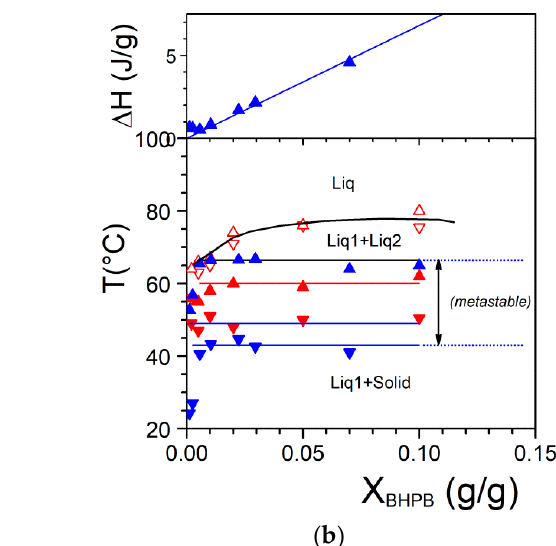
Figure 5. ( a ) A T-C phase where a monotectic transformation is observed. At the monotectic point the solid transforms into two liquids of differing compositions. The red lines show the shapes endotherms expected by DSC. The variations of the enthalpies associated with the different transitions are shown above. ( b ) Experimental example observed with BHPB-10 in trans -decahydronaphthalene (chemical structure in Appendix A Figure A3), X BHPB is in gram of organogelator per gram of gel. The red arrows stand for optical microscopy investigations, solid symbols = formation and melting of the gel, open symbols = liquid–liquid phase separation; blue arrows stand for the DSC data. Arrow orientation indicates cooling (down) or heating experiments (up); The slight discrepancy between DSC temperatures and optical microscopy findings arises from the use of different cooling and heating rates (5 °C/min and 0.5 °C/min); above Tamman’s diagram [30].